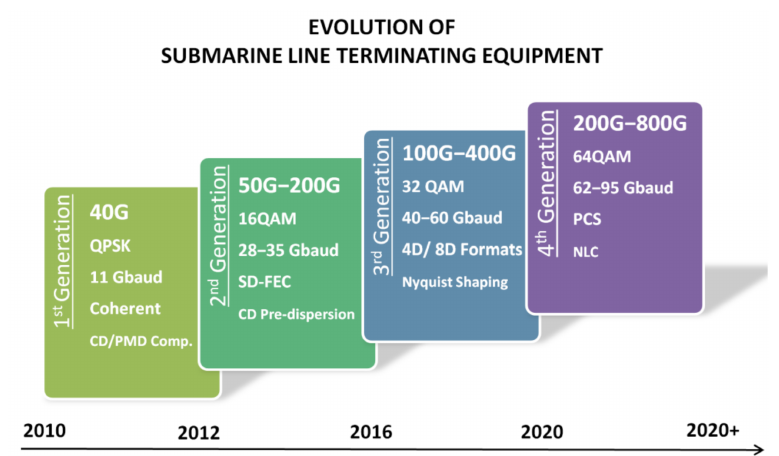
Figure 30. Branch types implemented by ROADMs–eBUs.